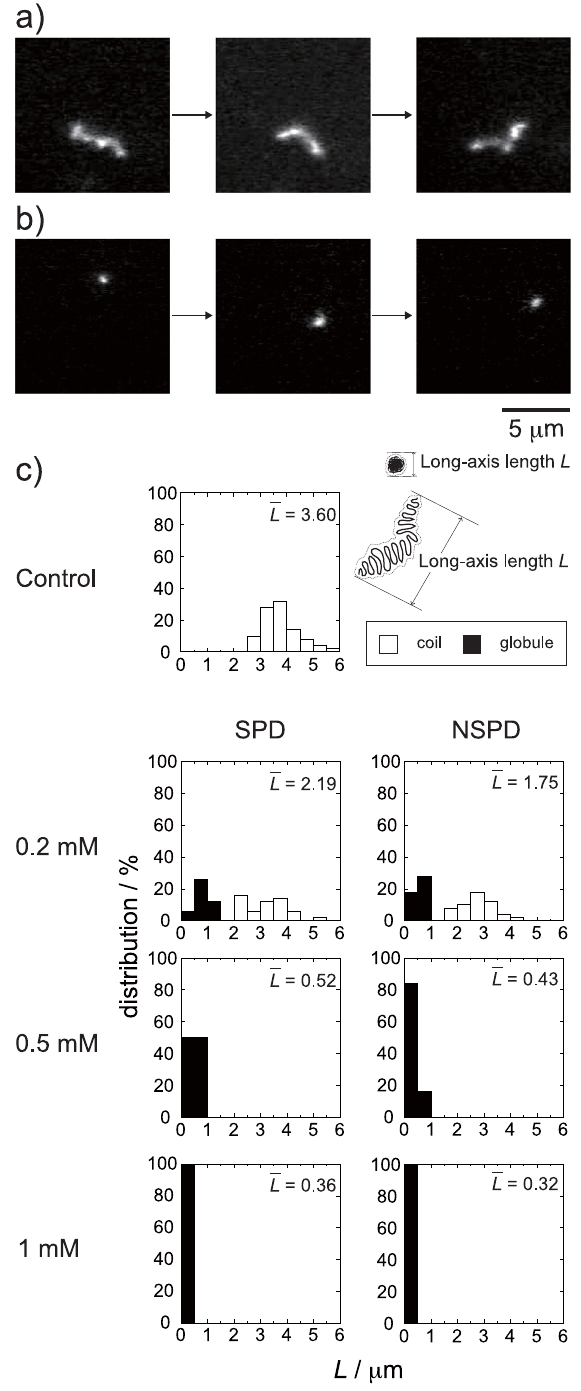
Figure 3. Typical FM image of a single T4 DNA molecule undergoing the Brownian motion in solution; ( a ) in the absence and, ( b ) in the presence of 1 mM NSPD. The time difference between neighbouring frames is 1 s. ( c ) Distribution of the long-axis length L of T4 DNA in solution at different concentrations of SPD and NSPD. The DNA concentration was fixed at 0.1 μ M in nucleotide units. L ( μ m) is the ensemble average for 50 DNA